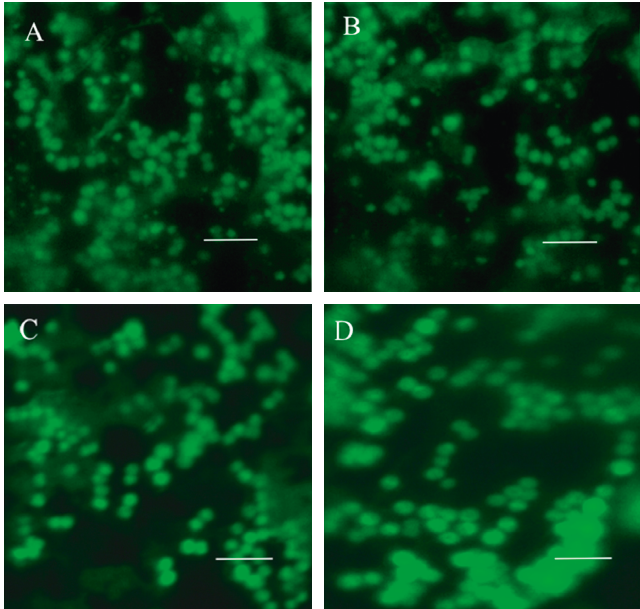
Figure 3: Epifluorescence photomicrograph of biofilms of Staphylococcus aureus isolates from food contact surfaces. Biofilms were developed on SS by 8 days of incubation in TSB with 0.5% glucose at 25 ° C: (A) S. aureus 4E; (B) S. aureus 9; (C) S. aureus 13; (D) S. aureus 19. The white bar scale indicates 10 μ m.